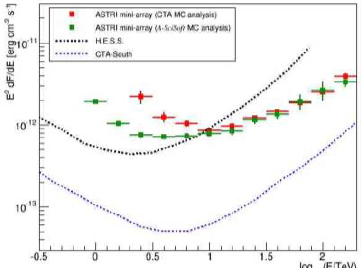
Figure 3. ASTRI pathfinder (9 telescopes, relative distance  250 m, and square layout) differential sensitivity curves (5  50 hours) achieved with the A-SciSoft MC analysis (green points) and with the CTA MC analysis [10]. The differential sensitivities of CTA-South (blue line) and H.E.S.S (black line) are shown for comparison. 4